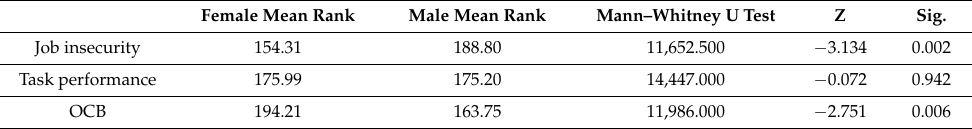
Table 4. Gender differences in job insecurity, task performance and OCB (Mann–Whitney test).